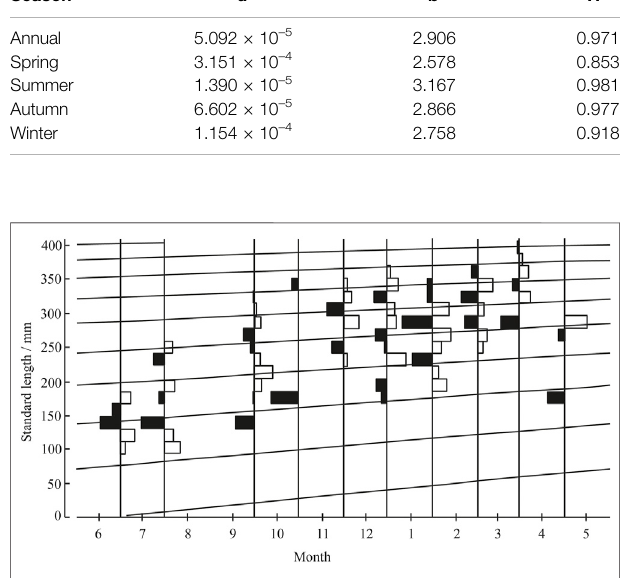
FIGURE 4 | Length frequency distribution data and growth curves estimated using ELEFAN method for Acanthopagrus schlegelii .